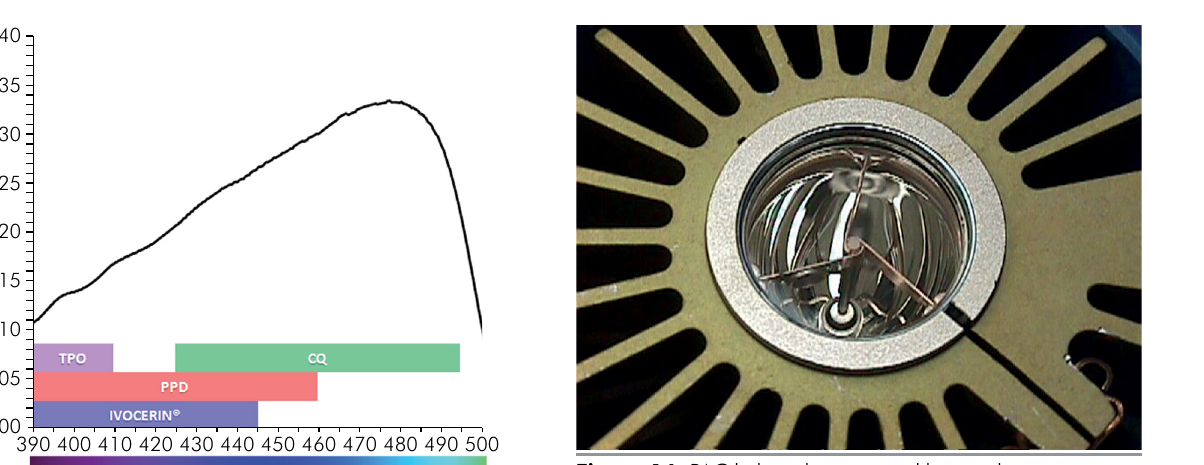
Figure 16. PAC light with associated heat sinking